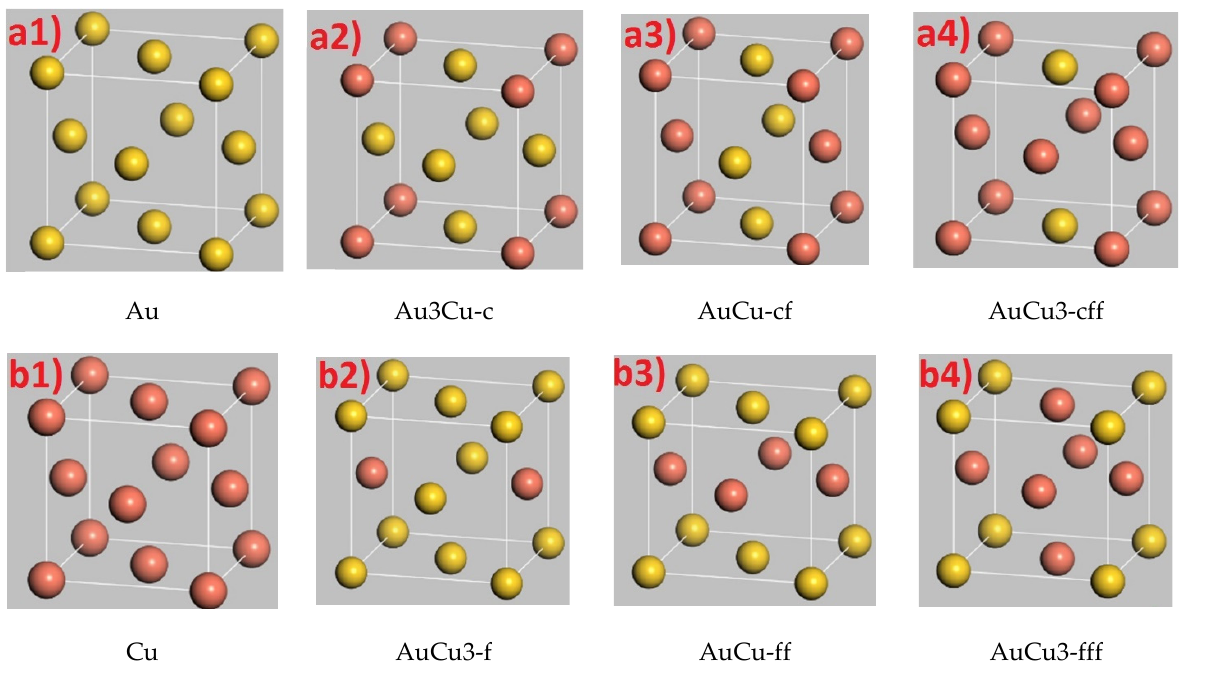
Figure 2. Optimized systems of Au, Au3Cu, AuCu, AuCu3, and Cu (yellow: Au, pink: Cu). The optimized lattice constants and the total energies of systems of Au, Cu, and their alloys were determined using LDA parametrized by Perdew–Wang (LDA-PWC) [49] and are shown in Figure